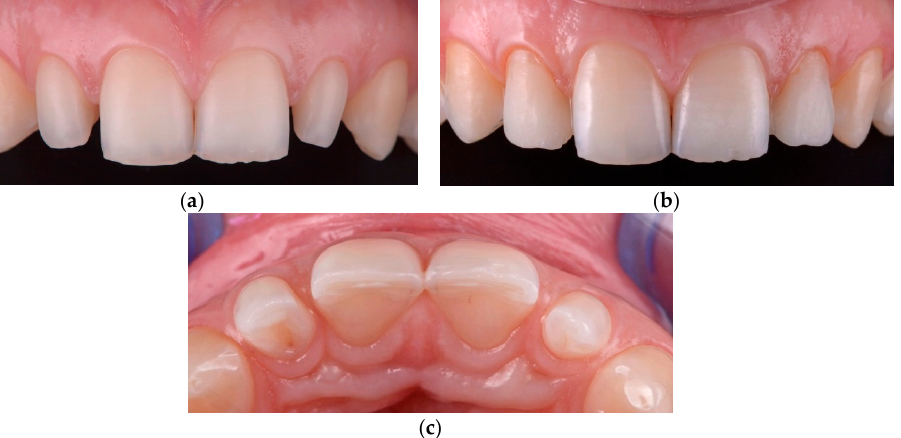
Figure 4. A microdontia of the lateral incisor: ( a ) initial situation; ( b ) additive direct mock-up, with enough space for final restoration; ( c ) no-prep technique applied by removing the composite from the natural teeth and preparing for impression.